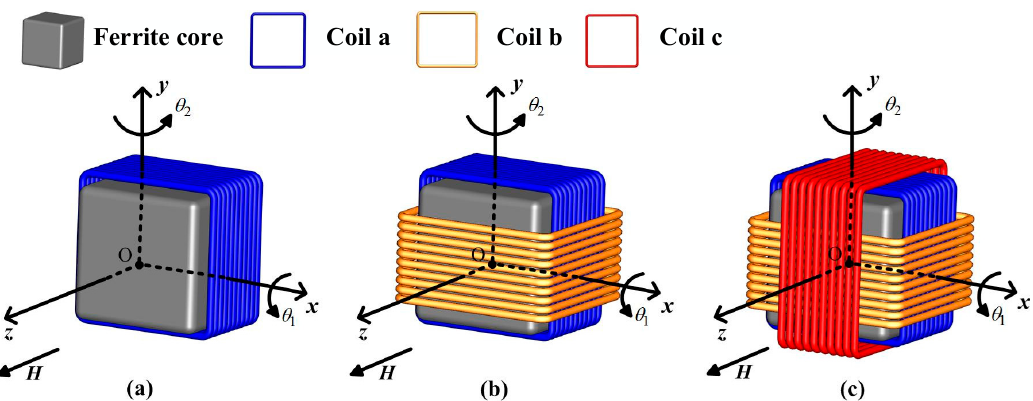
Figure 5. Attitude definition of three-dimensional orthogonal receiving coil. ( a ) One-dimensional orthogonal coil. ( b ) Two-dimensional orthogonal coil. ( c ) Three-dimensional orthogonal coil.